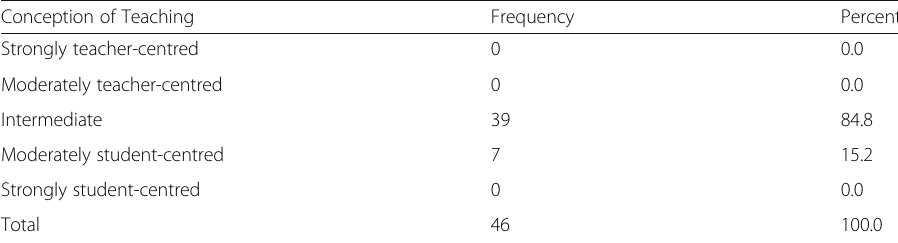
Table 2 Conceptions of teaching profiles Conception of Teaching